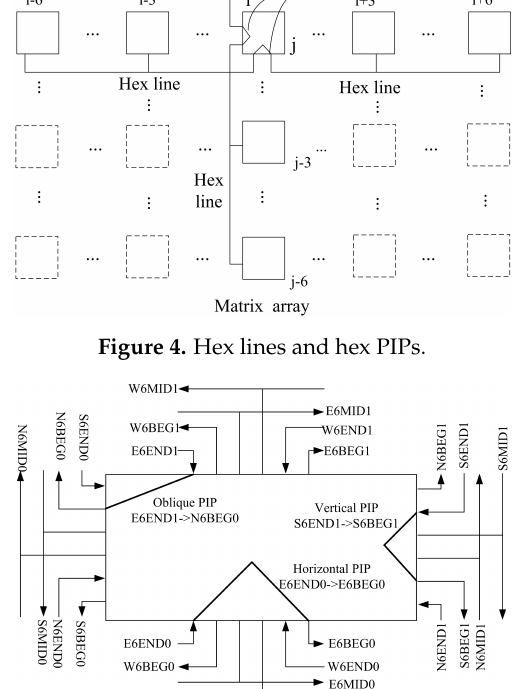
Figure 5. Hex PIPs in detail (vertical, horizontal, and oblique).